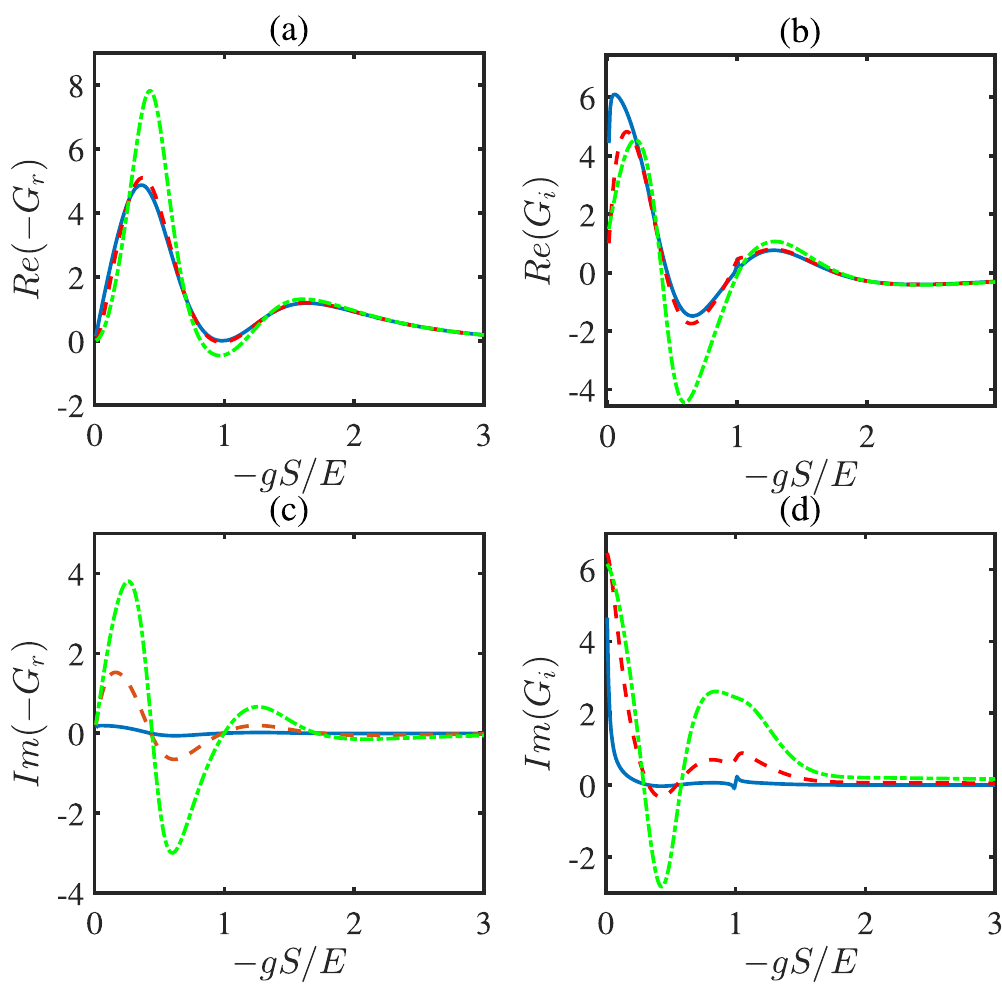
Figure 6. The real parts and the imaginary parts of G r and G i as a function of − gS / E with different values of γ / E . γ / E = 0.01 for the solid line, γ / E = 0.1 for the dashed line, and γ / E = 0.3 for the dotted line. The other parameters are chosen as θ = 0.3 π , l FM / a = 3.2, and μ 0 / E = 0.01. The units for G r , i are also e 2 / ħa 2